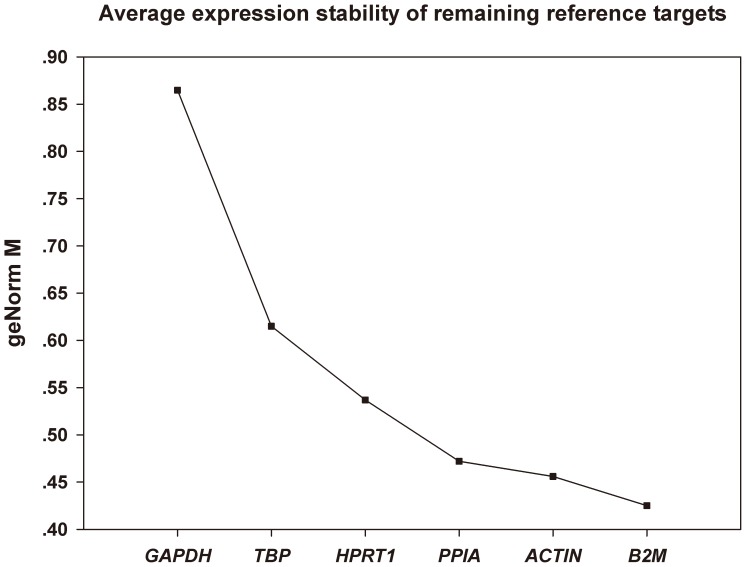
Average expression stability values of 6 candidate reference genes according to geNorm plus algorithm at the 4 time points.